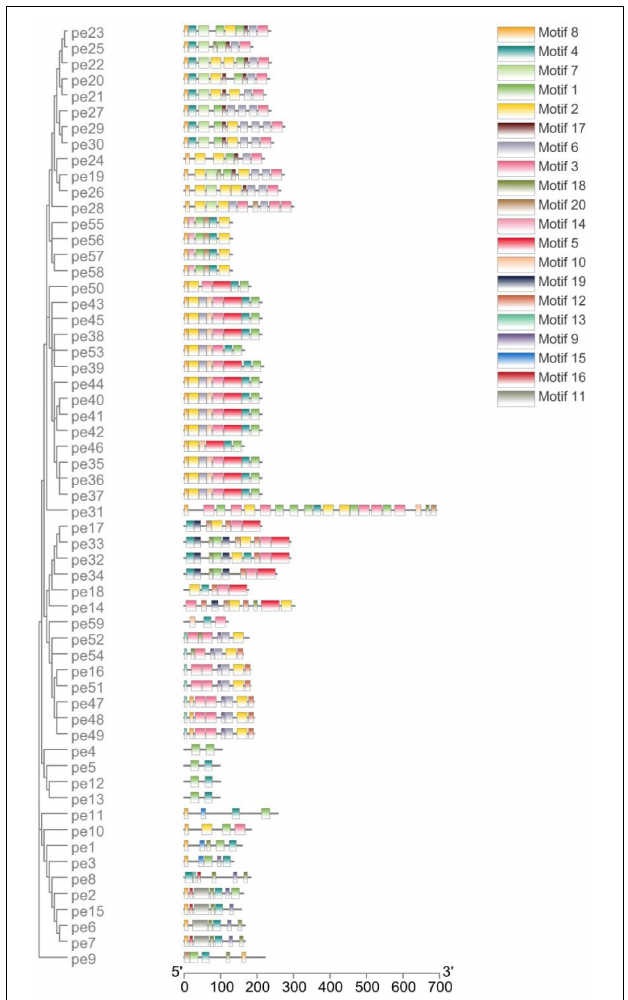
FIGURE 4 | Distribution of conserved motifs of high-sulfur protein